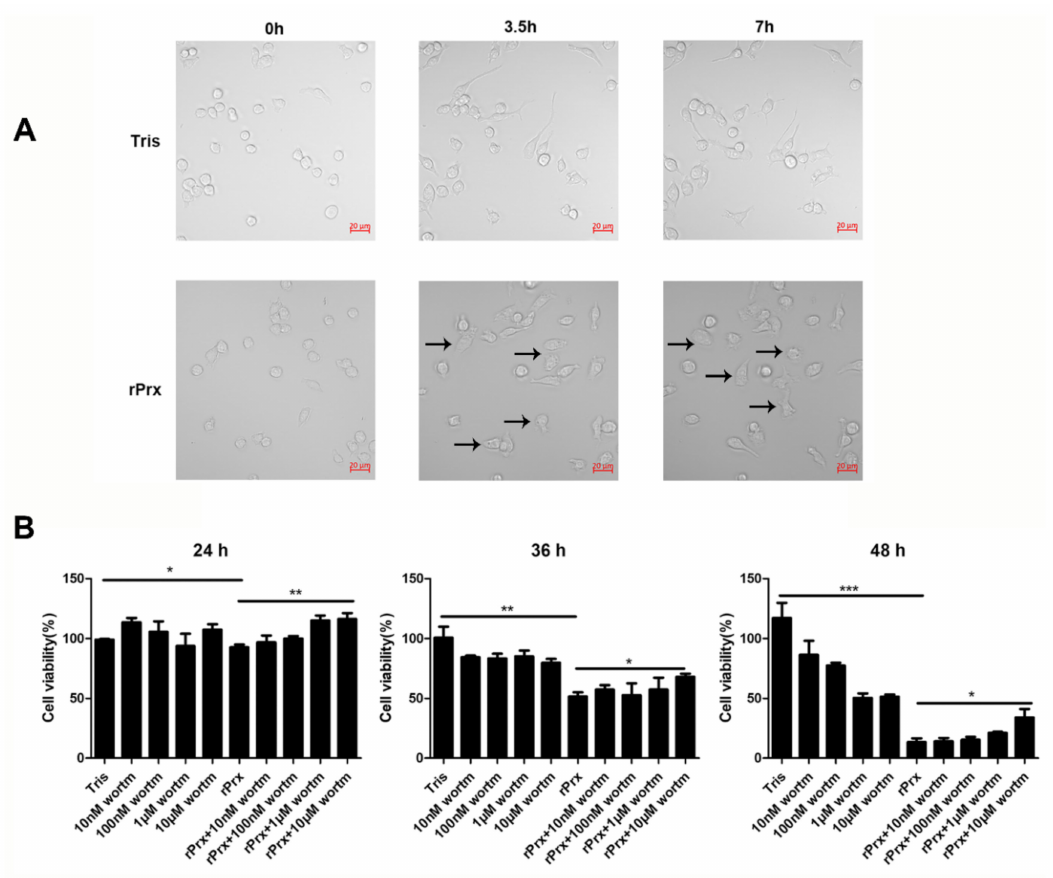
Figure 2. Eh -rPrx caused autophagy-dependent cell death. ( A ) Eh -rPrx treatment induced morphological changes in RAW264.7 cells. Cells were treated with serum-free Dulbecco’s modified Eagle’s medium (DMEM) containing Eh -rPrx (5 µ g / mL) and analyzed by di ff erential interference microscopy at the indicated times. Cells treated with Eh -rPrx showed morphology alterations: large area, vacuolation, and indistinct membranes (black arrows). Scale bar: 20 µ m. ( B ) Eh -rPrx-induced cell death was autophagy-dependent. RAW264.7 macrophages were pre-treated with wortmannin (10 nM, 100 nM, 1 µ M, and 10 µ M), then treated with Eh -rPrx (5 µ g / mL); cell viability was evaluated at the indicated times. The data are expressed as the mean ± SEM ( n = 5); * p < 0.05, ** p < 0.01, and *** p <